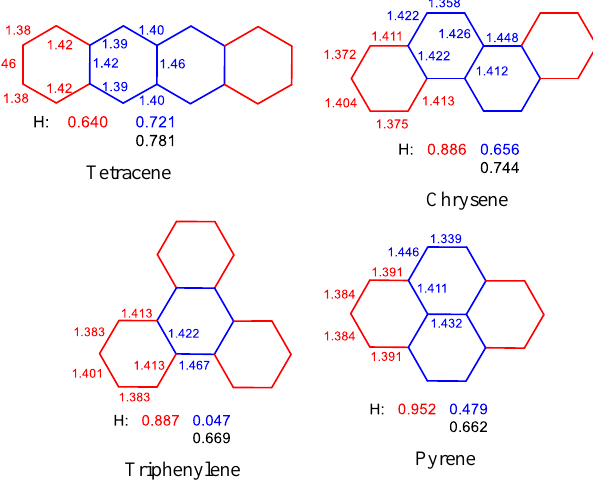
Figure 5. Structures and HOMA values of each ring in some polycyclic aromatic hydrocarbons (bond lengths in Å ). Symmetric equivalent rings are marked in the same color. HOMA value of the perimeter of molecule marked in black. Tetracene: X-ray data obtained in Ref. [52] and reevaluated in Ref. [53], chrysene: B3LYP/cc-pVTZ [51], triphenylene: B3LYP/6-31G(d) [54], and pyrene: RHF/6- 31G results [55].